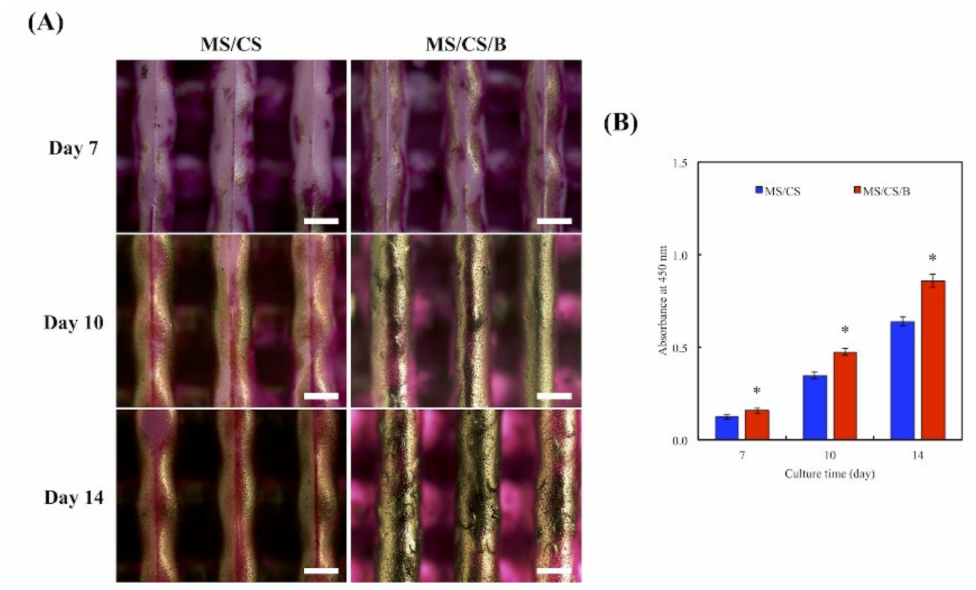
Figure 10. ( A ) Alizarin red S staining and ( B ) quantification of hDPSC calcium mineral deposits cultured on specimens for 7, 10, and 14 days. * indicates a significant difference ( p < 0.05) when compared to MS/CS. The scale bar of the Optical microscope photograph is 400 µ